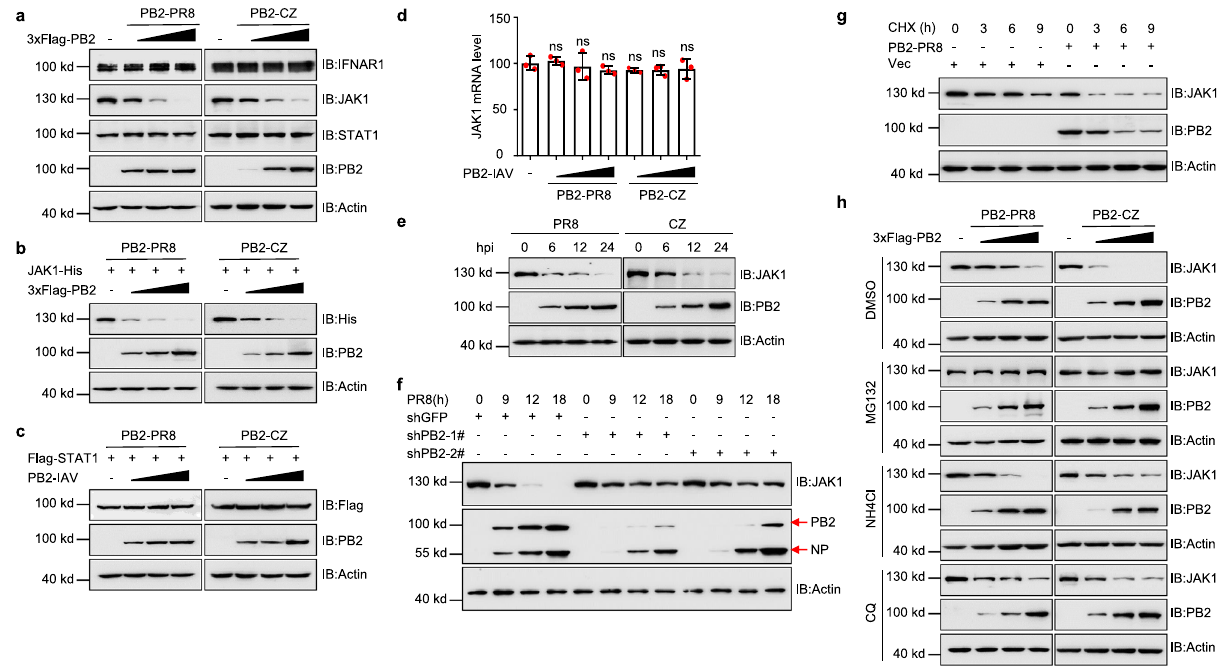
Fig. 2 | IAV PB2 promotes the degradation of JAK1. a Immunoblots of HEK293TcellsweretransfectedwithdifferentconcentrationsofPB2plasmidsfrom PR8 (left) or CZ (right). b , c Immunoblots of HEK293T cells transfected with JAK1- His ( b ) or Flag-STAT1 ( c ) with different concentrations of PB2 plasmids. d qPCR analysisof JAK1 mRNA levelin A549 cellstransfected with different concentrations ofPB2plasmids( n =3biologicallyindependentsamples).Dataarepresentedasthe mean±SD.Statisticalsigni fi cancewasdeterminedbyunpairedtwo-tailedStudent ’ s